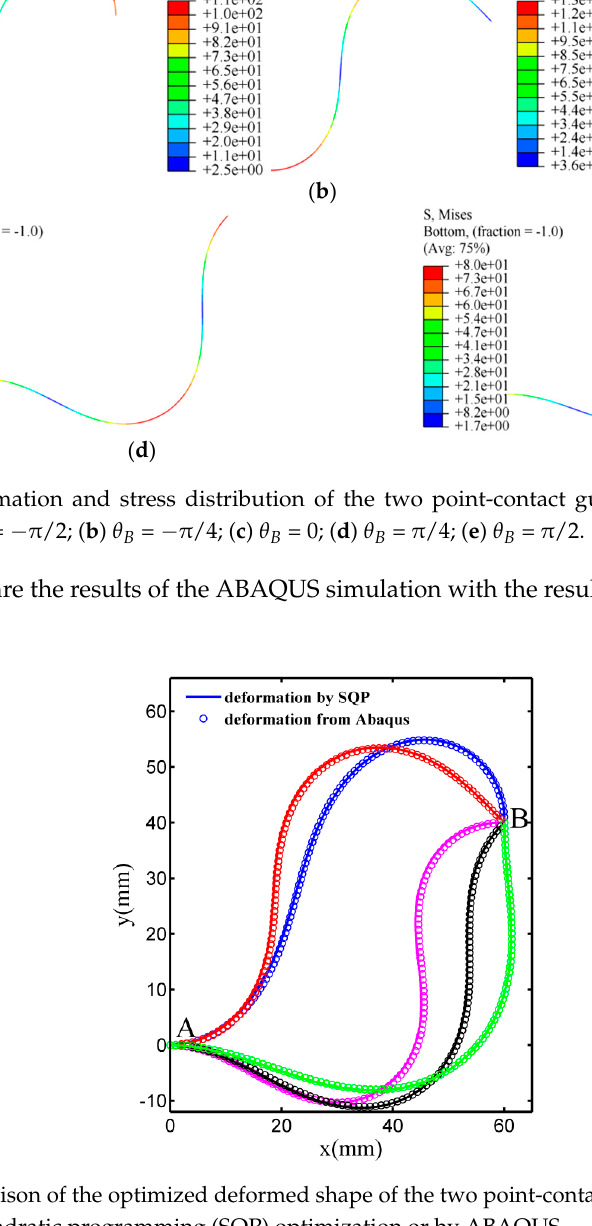
( b ) Figure 6. Optimized guidewire shapes for different contact conditions. ( a ) The equation for an oblique vessel wall is y = 1.5 x − 30; ( b ) The equation for a vertical vessel wall is x = 45 . 3.2. Deformation by ABAQUS Simulation ABAQUS is widely considered to be a powerful finite element software with a library of various types of material models. Here, ABAQUS is used to simulate the deformation of the guidewire for the two-point contact situation seen in Figure 4. The simulation parameters of the guidewire in ABAQUS are shown in Table 3. Table 3. Input data for the ABAQUS simulation of the two-point contact guidewire problem. Element